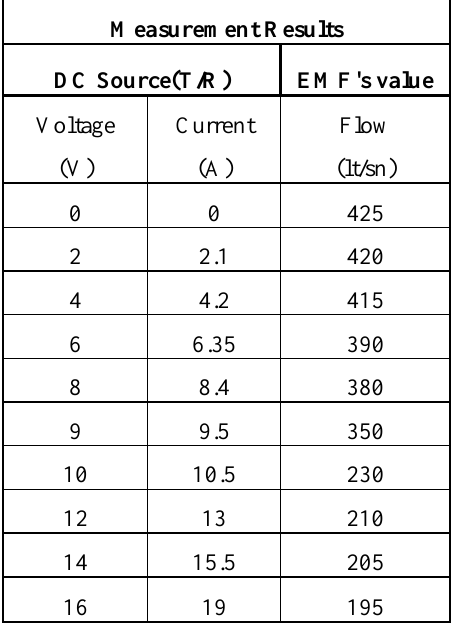
Table 1. Experimental measurement